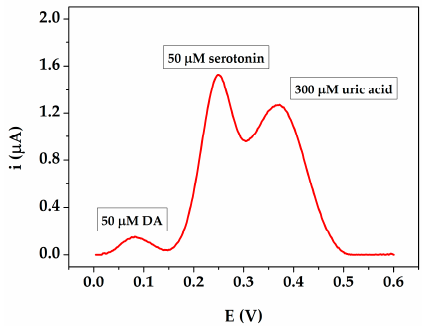
Figure 6. Differential pulse voltammograms performed with 50 μ M DA, 300 μ M uric acid and 50 μ M Figure 6. Di ff erential pulse voltammograms performed with 50 µ M DA, 300 µ M uric acid and 50 µ M serotonin in 0.1 M PBS pH 7.0. Experimental parameters: potential range from +5 mV to +600 mV, serotonin in 0.1 M PBS pH 7.0. Experimental parameters: potential range from + 5 mV to + 600 mV, scan scan rate 4 mV/s, step potential 2 mV, pulse potential 50 mV, pulse time 0.05 s. rate 4 mV / s, step potential 2 mV, pulse potential 50 mV, pulse time 0.05